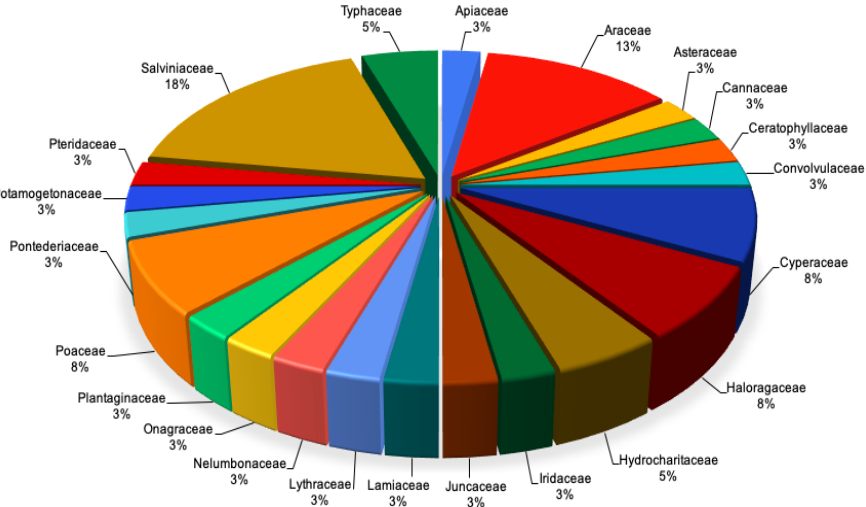
Figure 1. Twenty-two families corresponding to 40 species reviewed in the present study reported due their water phytoremediation capacity. The higher the percentage, the higher the representation in the analysis, implying more species for each family. References are listed in Table 1.